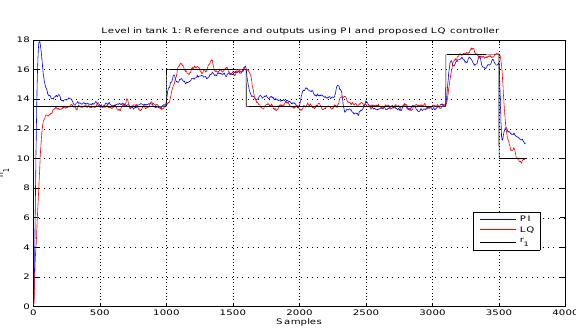
Figure 8: Quadruple tank process. Level in tank one. Illustrating the reference and the outputs from the process controlled by two single loop PI controllers, and the proposed LQ opti- mal controller with integral action. The LQ controller was constructed by using the DSR method for system identification. The DSR model was used to identify a Kalman filter for the system. The states were estimated with this Kalman filter and the determinis- tic part of the model was used to design the controller.